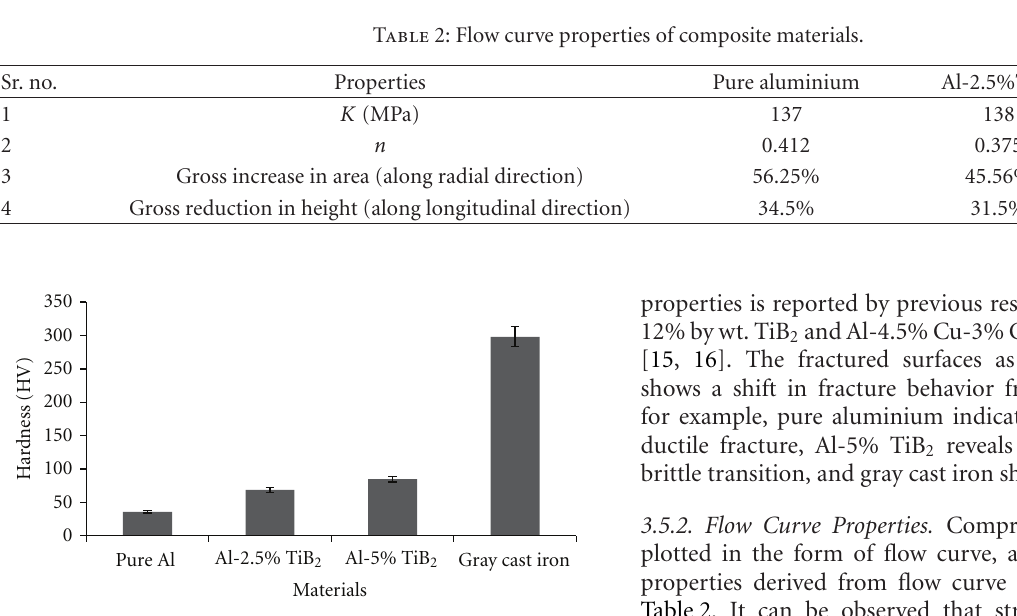
Figure 7: Hardness variation of cast aluminium, Al-TiB 2 compos- ites, and gray cast